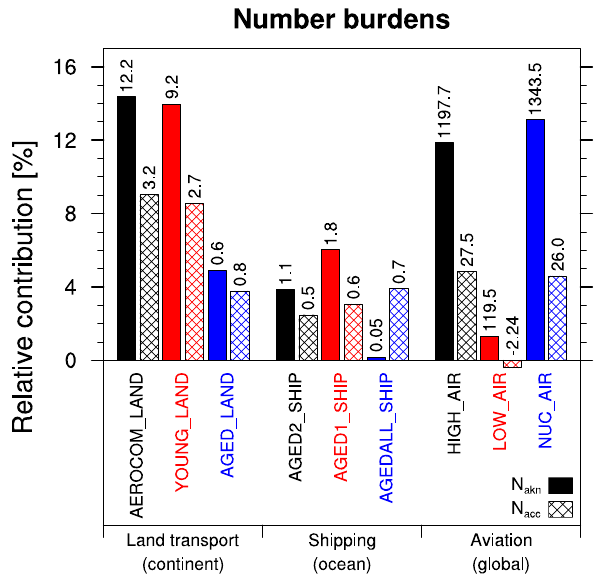
Fig. 7. Relative effects of the transport sectors on the multi-year av- erage number burdens of particles in the Aitken (solid pattern) and accumulation (hatched pattern) mode size ranges as obtained for the different sensitivity analyses. The names of the sensitivity experi- ment are written at the bottom of the corresponding bars. Similarly to Fig. 3, land transport and shipping contributions are integrated over continents and oceans, respectively, and over the two lower- most model layers ( ∼ 0–230m). Model layers from 7 to 9 ( ∼ 8– 13km) are considered for aviation. The relative effect is calculated as a relative contribution, consistently integrating the burdens over the same domains. The number on top of each bar shows the cor- responding absolute contributions (in units of 10 24 particles). The plotted values are statistically significant according to a uni-variate t test (5% error